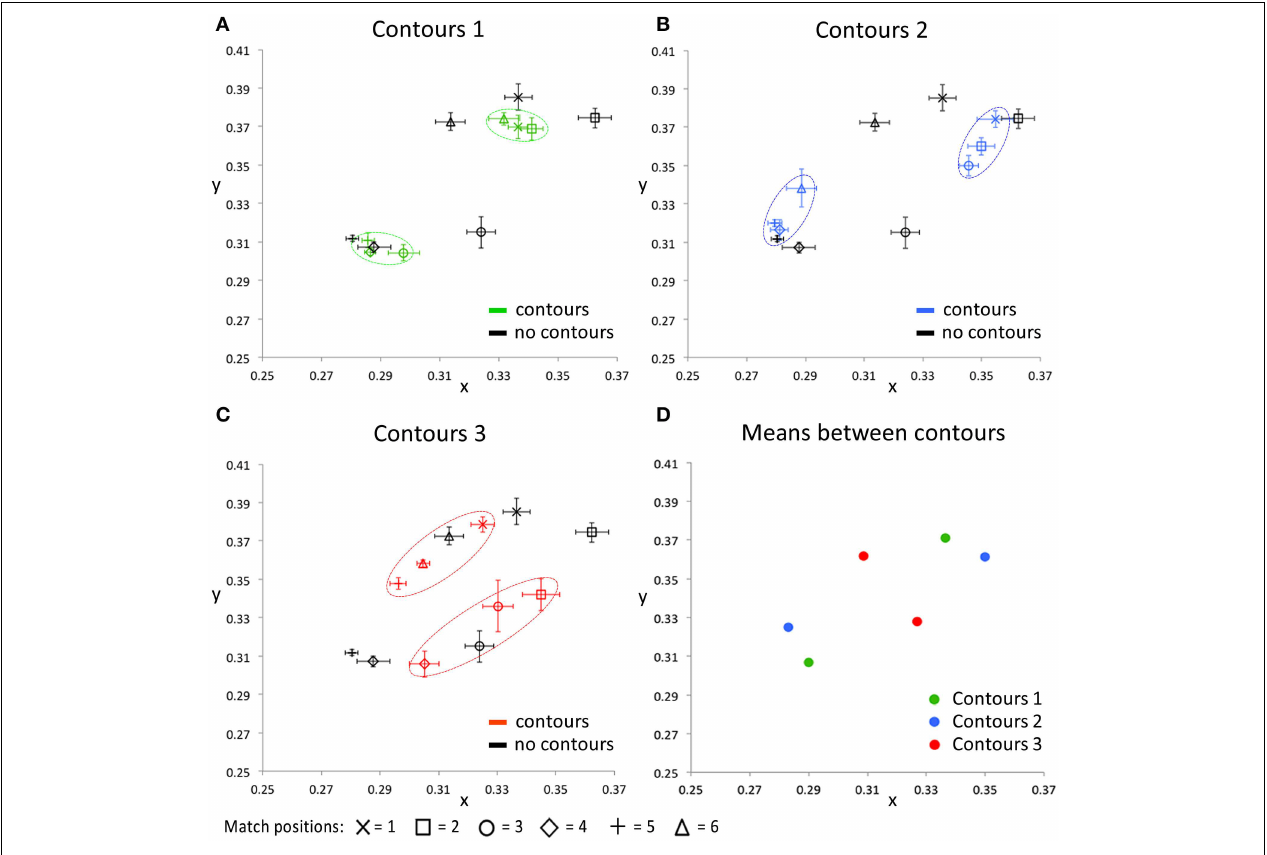
FIGURE 7 | The CIE xy values for all conditions averaged over all five participants. The black symbols in (A–C) indicate the matching responses on the image without black outlines ( Figure 5 , right image), for all tested locations, respectively. In addition, each of these 3 panels shows the matching response on one of the contour conditions, for the same tested locations. Error bars represent standard errors (across observers) for the CIE x and y dimensions, respectively. The dashed, colored ovals show the